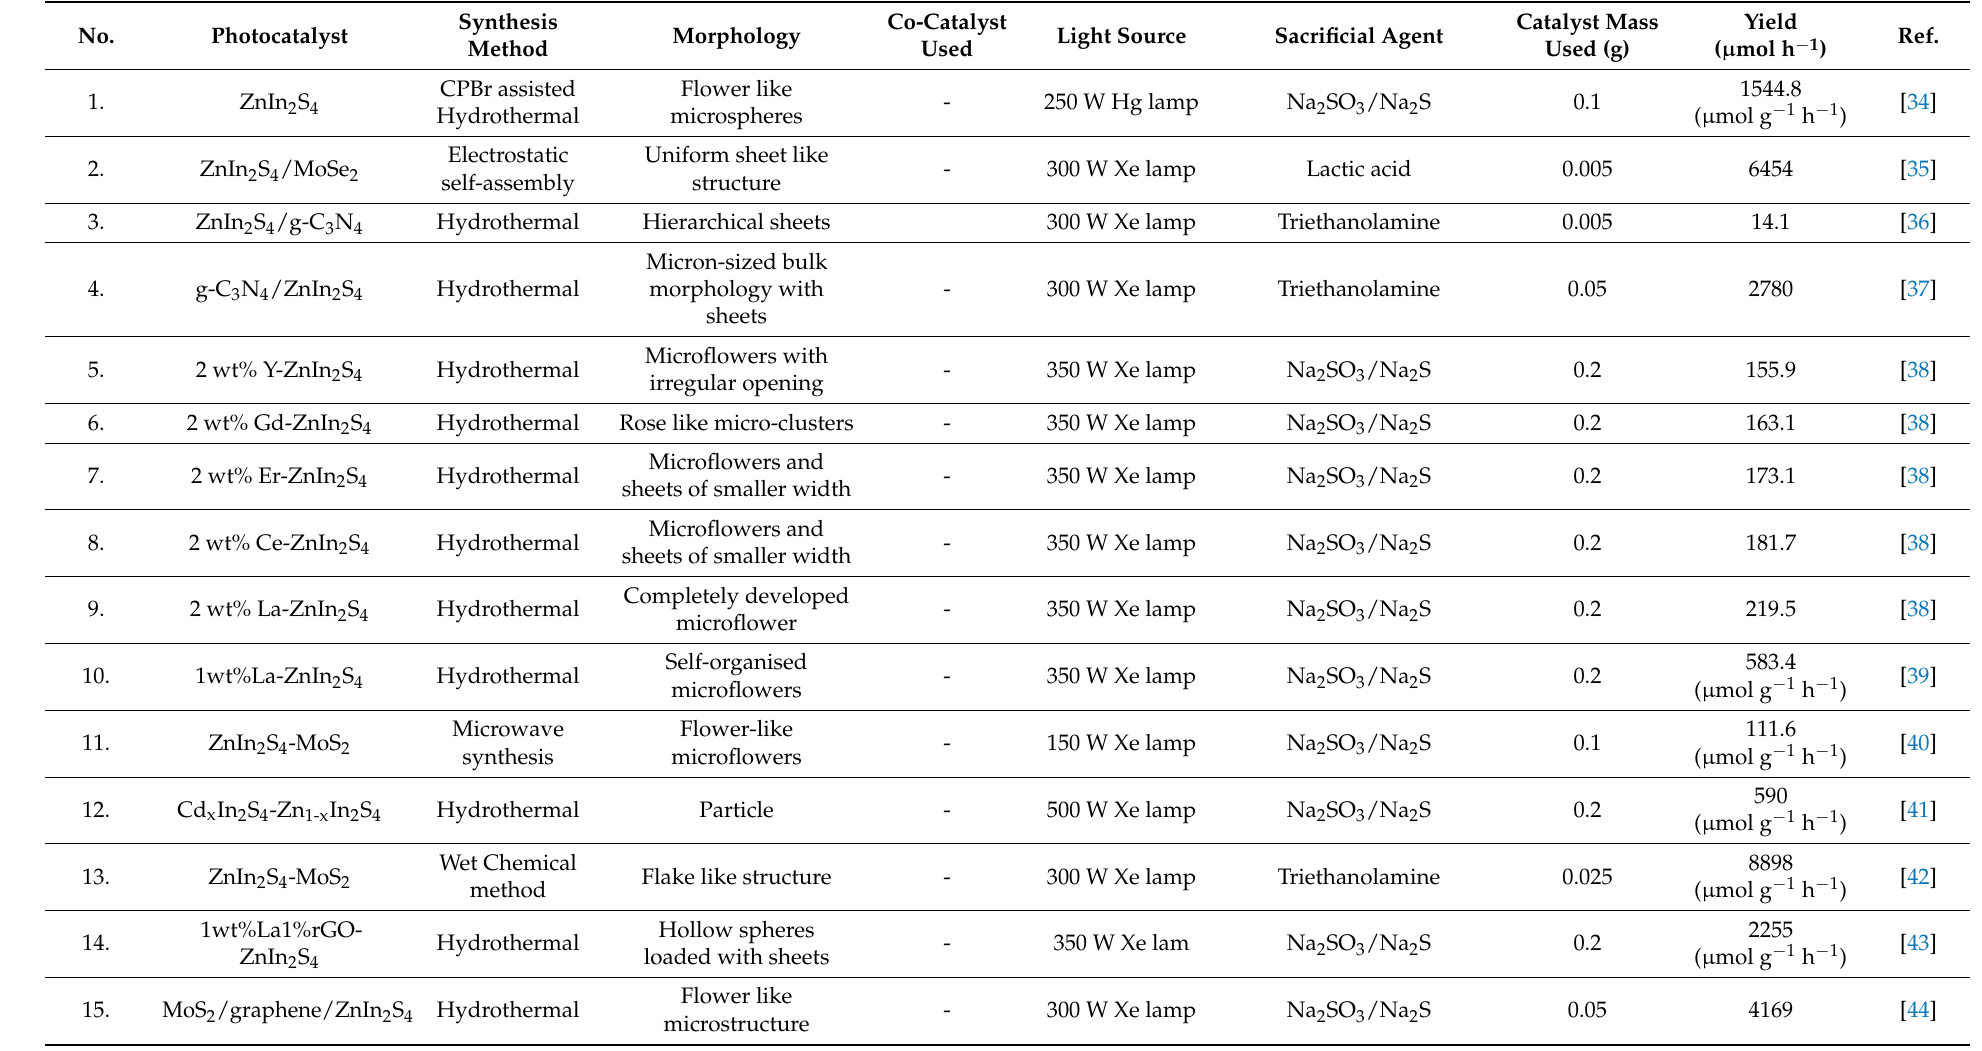
Table 1. Photocatalytic activity of ZnIn 2 S 4 -based material in H 2 generation with respective